Question: Express in one sentence what the figure is showing.
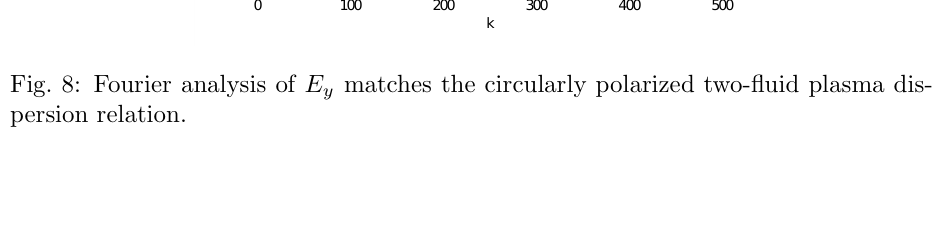
Answer: demonstrates that the Fourier analysis has three dominant modes cor- responding to the three branches of the L and R modes. This test demonstrates the viability of using HDG to solve large-scale coupled plasma differential equations and the validity of the implemented tools to ensure correctness and simplify implementing such solvers. Figure 9 shows the numerical stability conditions for an equivalent explicit explicit RK4. For analysis purposes the implicit scheme used ∆t = 6.28 × 10−3. While an explicit RK4 DG solver can run a N = 0 basis with this timestep, higher degree basis require a smaller timestep. Define the timestep ratio gain as the implicit timestep ∆t used divided by the maximum stable explicit timestep. In this case there is a timestep ratio gain of 2.2 for N = 1 and 4.4 for N = 2 over an explicit RKDG method. The primary reason these ratios are low is that the original test conditions were setup such that it is feasible to run and benchmark an explicit RKDG cod